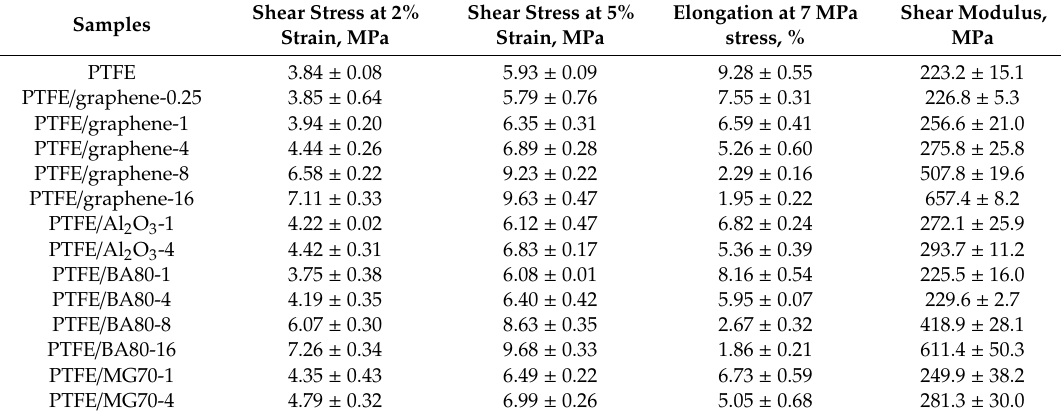
Figure 9. Shear and tensile elongation of unfilled and filled PTFE samples. The grey and green transparent lines display the shear and tensile elongation of neat PTFE, respectively. Table 6. Average shear stress at 2% and 5% strain, average elongation at 7 MPa stress and average shear modulus of the sintered